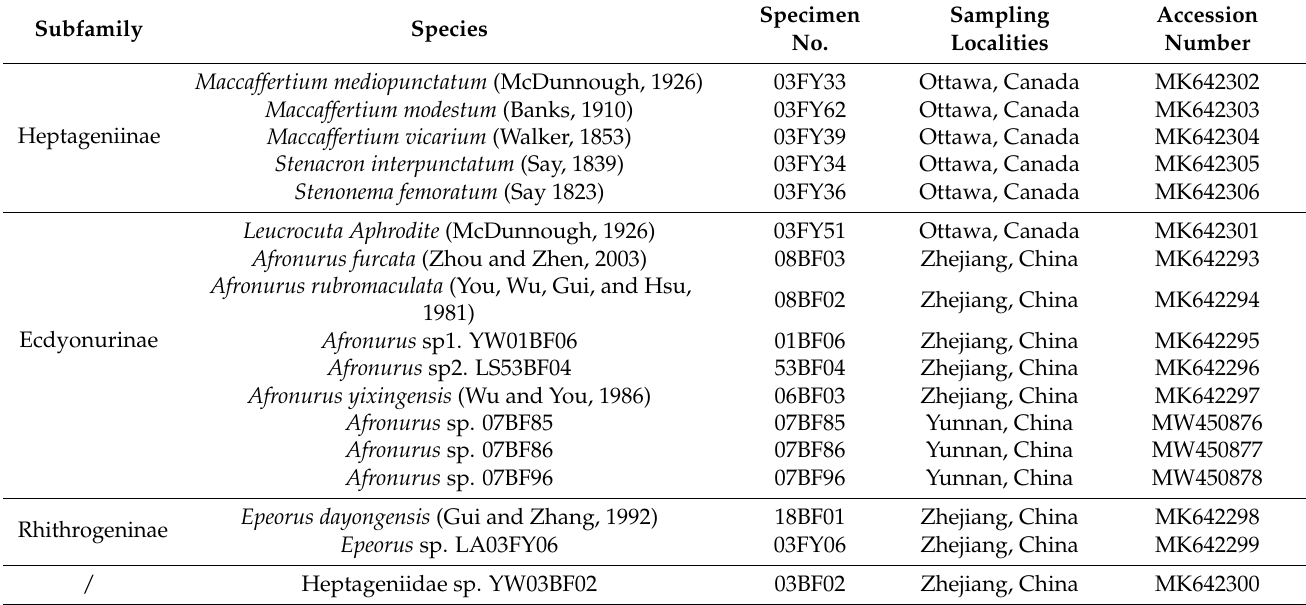
Table 1. Information on specimen sources of the samples used in this study and NCBI Genbank accession numbers. Subfamily Species